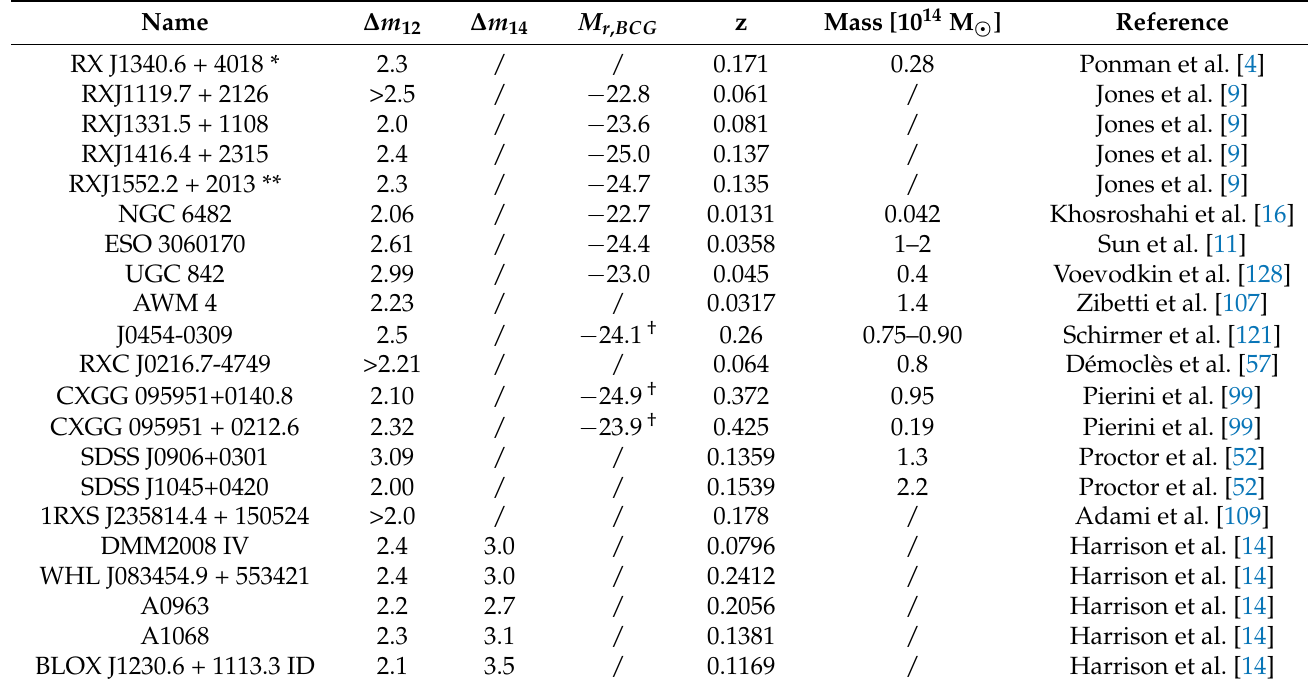
Table 1. A non-exhaustive list of confirmed FGs for which at least ∆ m 12 ≥ 2 (and eventually ∆ m 14 ≥ 2.5) is computed within half the virial radius in the